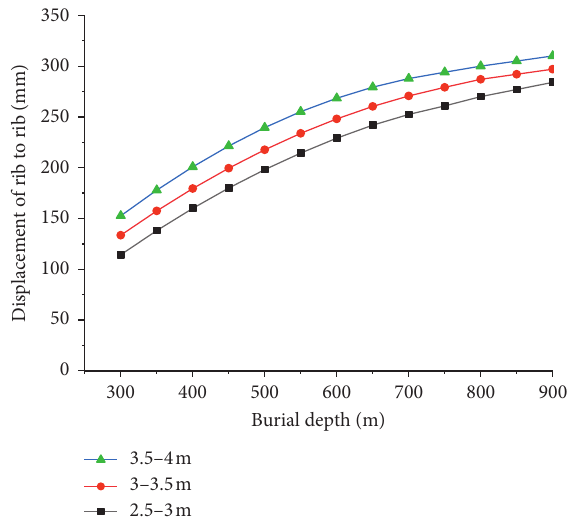
Figure 33: Displacement of rib to rib with different heights. Table 7: Comparison of displacement of new digging roadway rib to